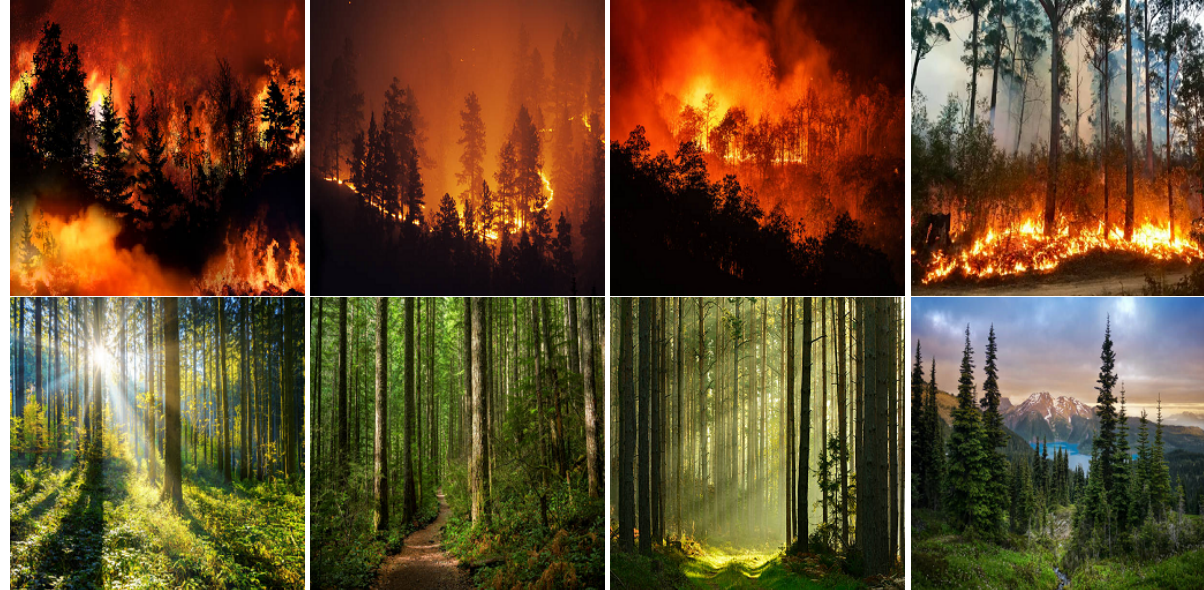
Figure 14. Examples from the FiSmo dataset. ( Top ): Fire images; ( Bottom ): non-fire images.